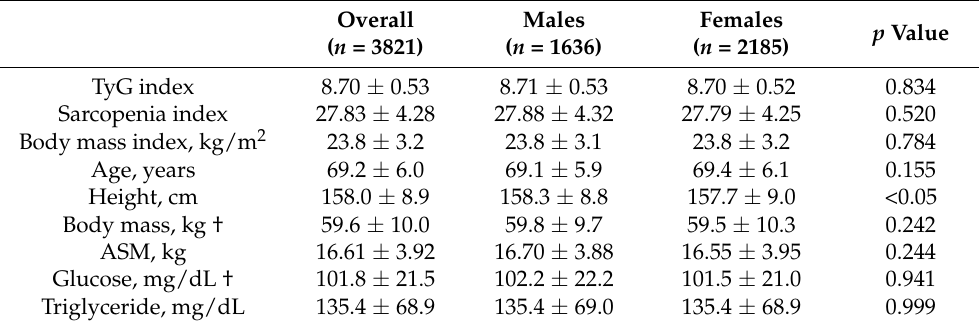
Table 1. Characteristics of the study participants and differences between males and